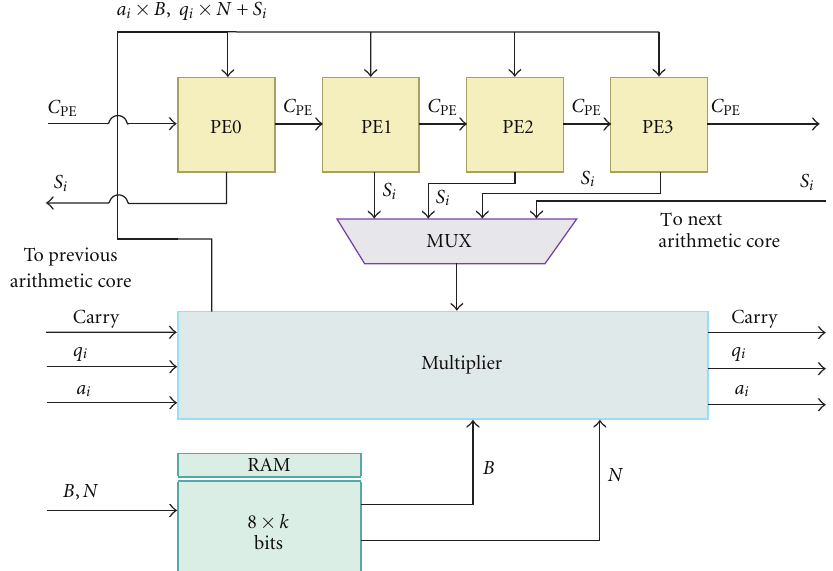
Figure 7: The Arithmetic core architecture.